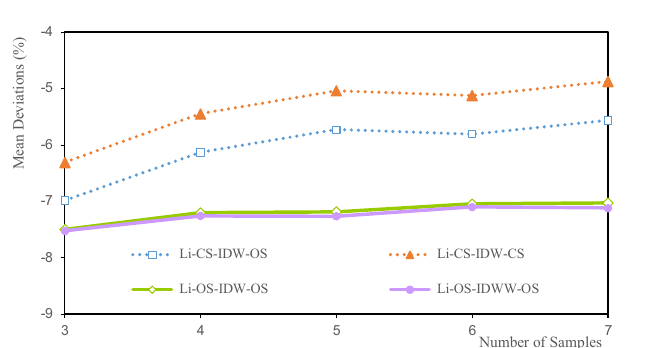
Figure 11. Deviation of the Li average grade.